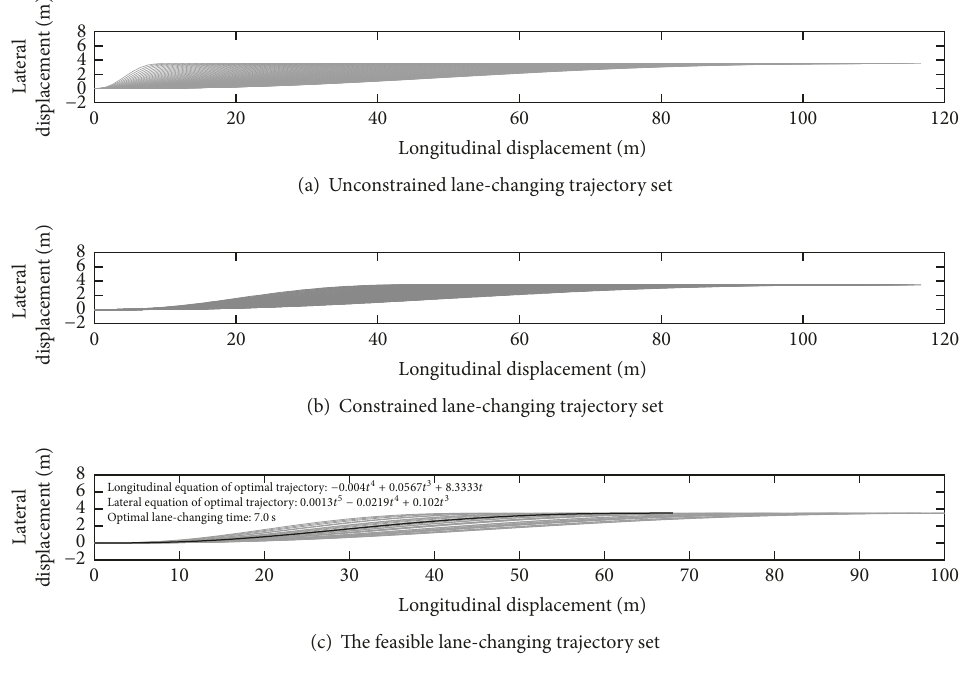
Figure 6: Lane-changing trajectory set of 𝑀 under the uniform coordination of 𝐹 𝑑